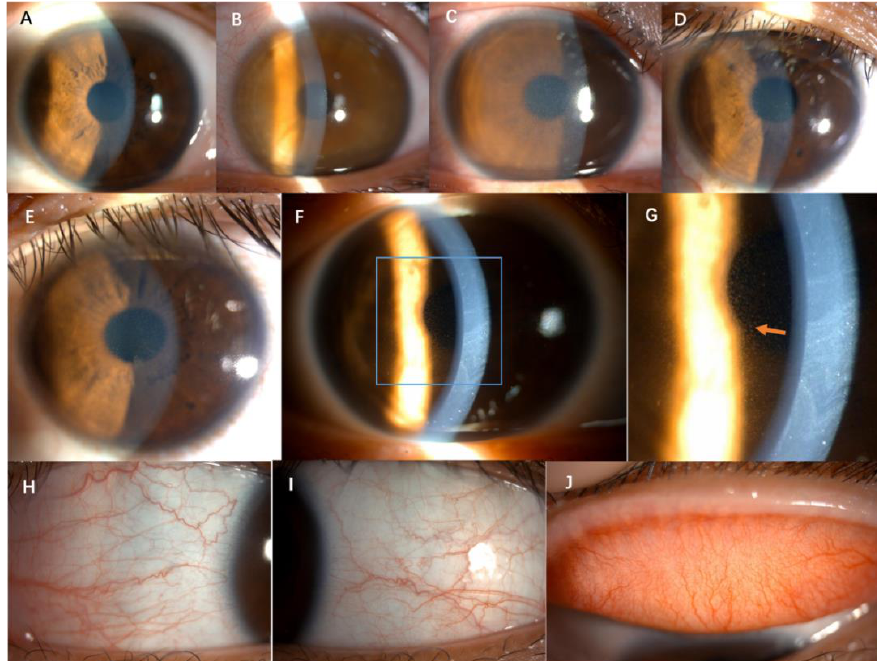
Figure 1. Anterior segment slit-lamp photography of six cases. ( A – F ), corneal diffuse dust-like opacity and edema; ( G ), the arrow shows diffuse dust-like opacity in the cornea epithelium by retro illumination. ( H – J ), mild hyperemia of the conjunctiva, no follicles or papillae (1/10 case).